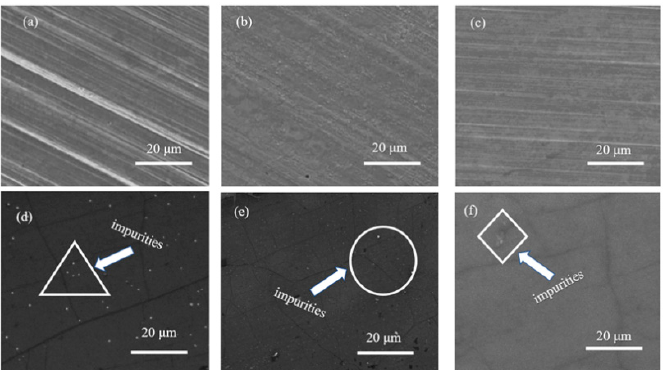
Figure 2. SEM of ( a ) pristine copper foil without pre-treatment; ( b ) copper foil treated with AP solution; ( c ) copper foil treated with AA solution; ( d ) graphene grown on pristine copper foil without pre-treatment; ( e ) graphene grown on copper foil treated with AP solution; ( f ) graphene grown on copper foil treated with AA solution.